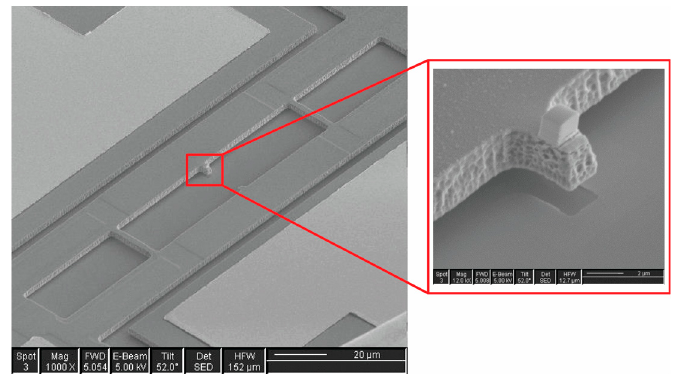
Figure 33. A resonant mass sensor based on coupled resonators. Note the addition of platinum sheets used for characterization of the sensor [269]. © 2016 IEEE. Reprinted with permission from Improving sensitivity of resonant sensor systems through strong mechanical coupling by M.S. Hajhashemi in J. Microelectromech. Syst. , 2016.